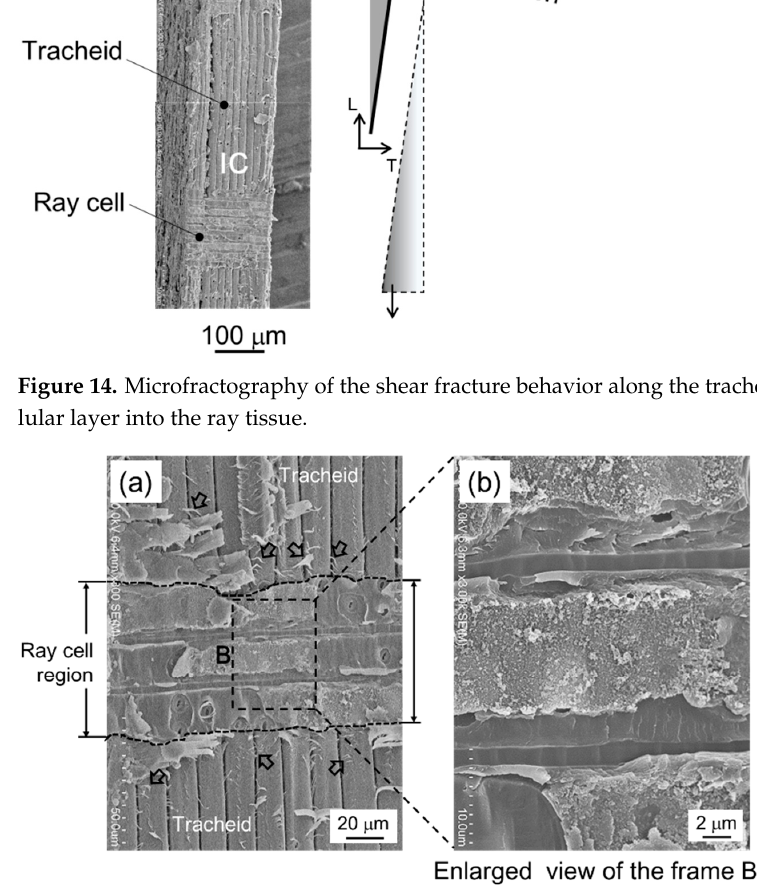
Figure 15. SEM image showing the behavior of the shear fracture. Arrows indicate tearing fibril fragments in the intercell-failed tracheids. The enlarged view ( b ) is section B surrounded by the dashed lines in ( a ).